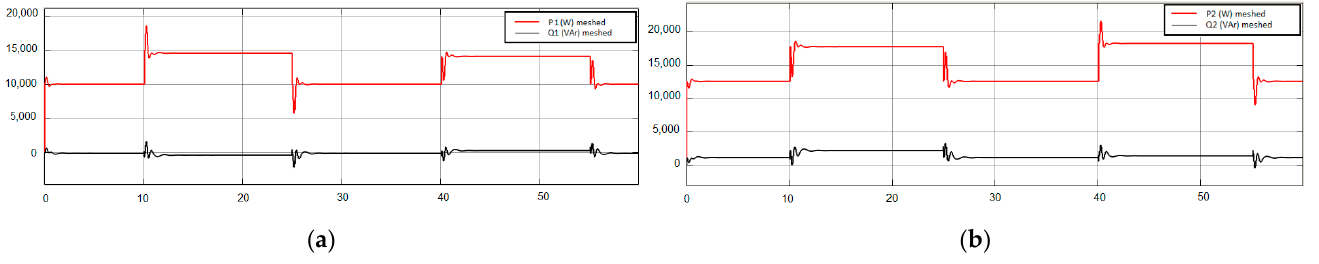
Figure 16 . Simulation results for active and reactive power delivered by each feeder; ( a ) P and Q provided from feeder A; ( b ) P and Q provided from feeder B.